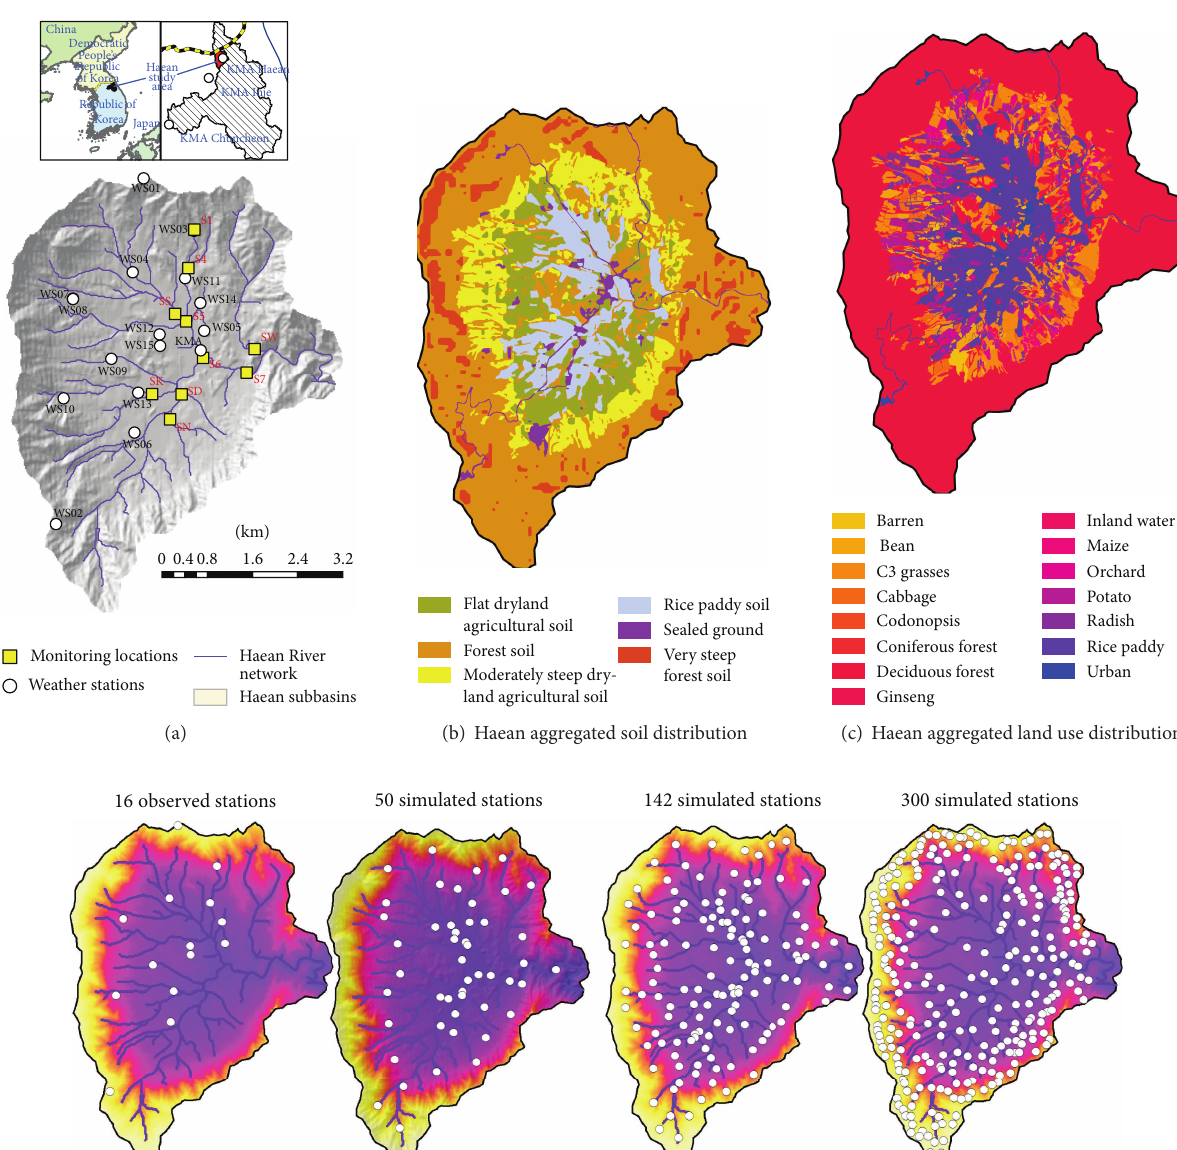
surface water. The weighted calibration procedure that Shope et al. [29] describe enabled the baseflow contributions to be an important calibration metric for model